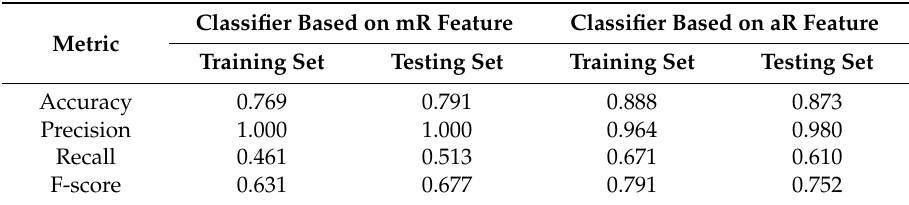
Table 7. Performance of simple threshold classifiers on training and testing set.